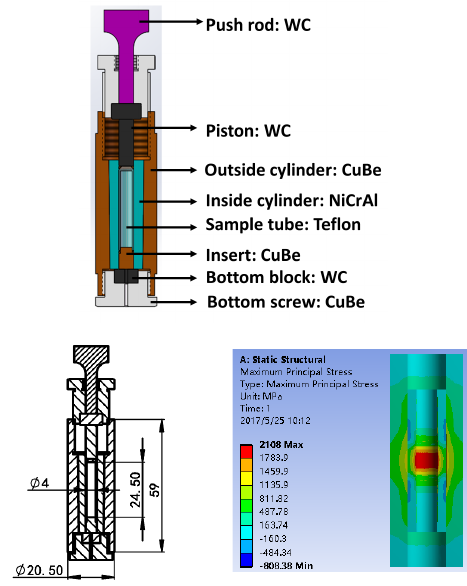
Fig. 1. The sketch, dimensions, and maximum stress distribution with FEA are shown for the Hybrid – Cell .